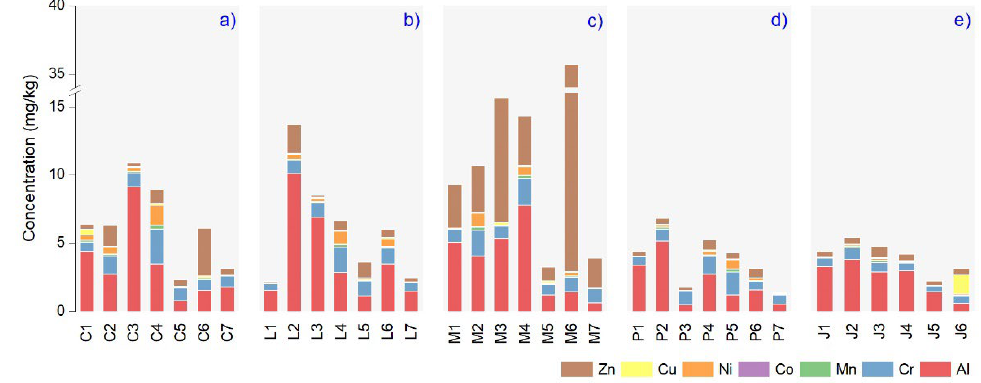
Figure 2. The micronutrients elemental levels (mg/kg) in samples analyzed: ( a ) Thymus vulgaris L., ( b ) Lavandula augustifolia Mill., ( c ) Mentha × pipperita L., ( d ) Pinus sylvestris L., ( e ) Juniperus communis L.